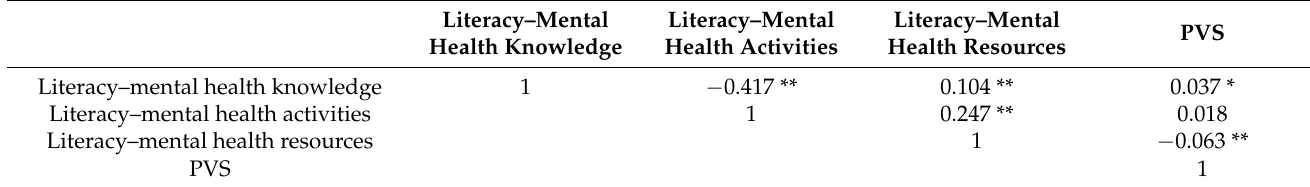
Table 5. Correlation between MHKQ and PVS.